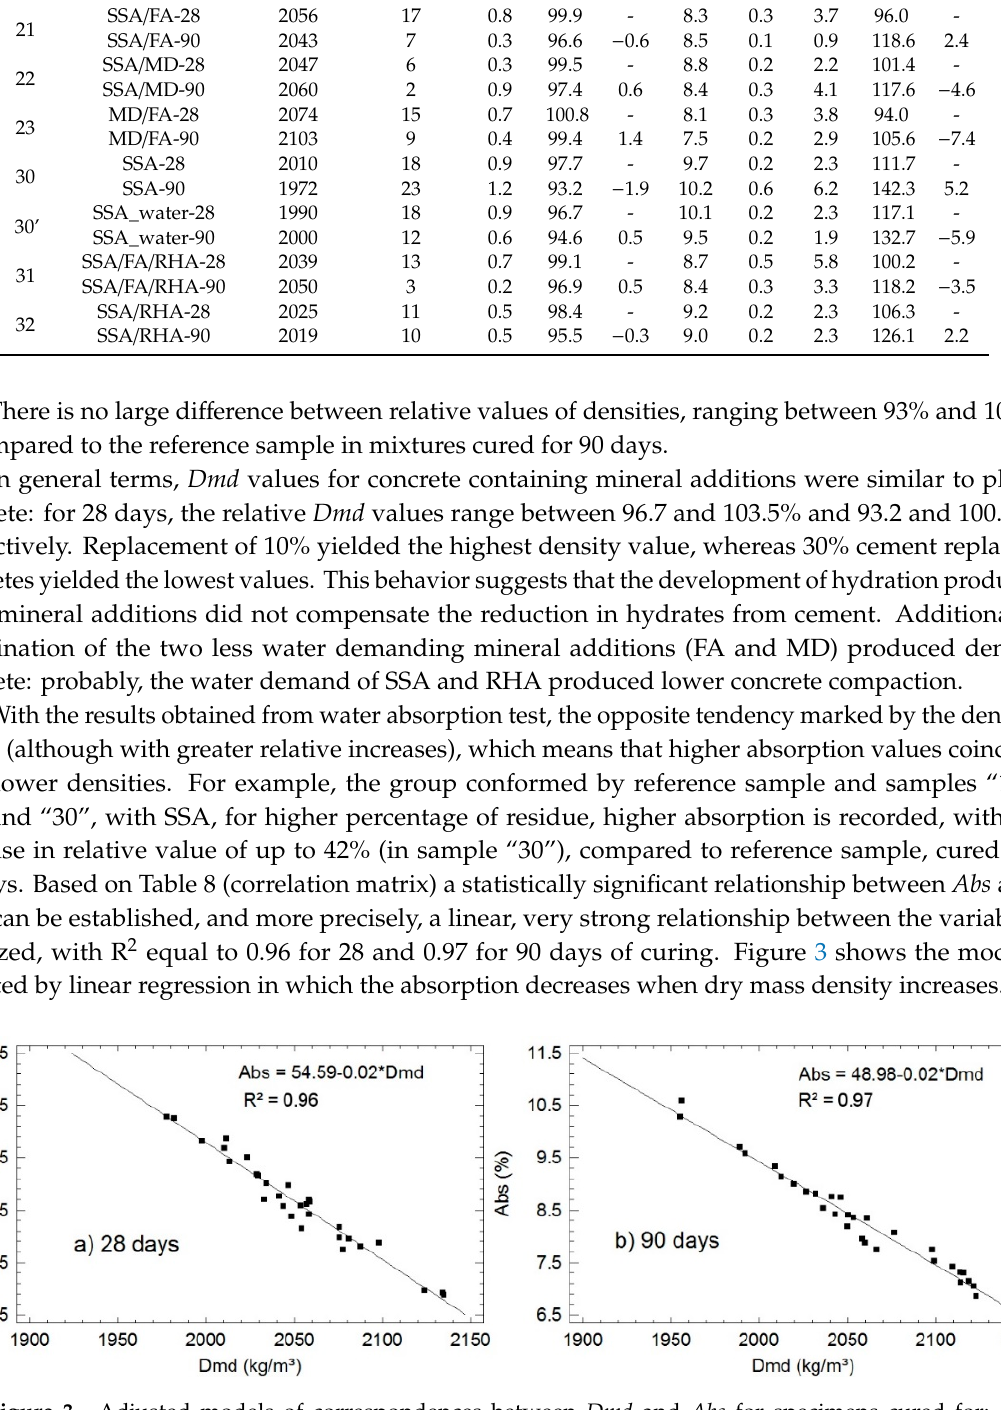
Figure 3. Adjusted models of correspondences between Dmd and Abs for specimens cured for: ( a ) 28 days; and ( b ) 90 days.